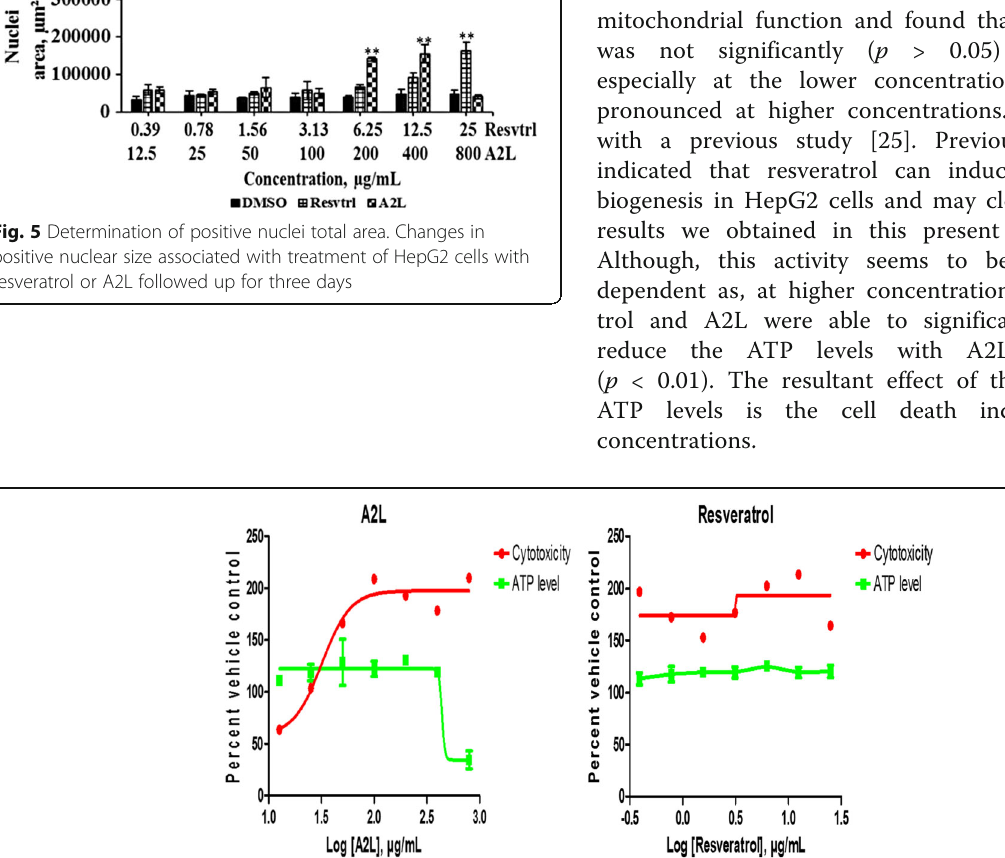
Fig. 6 Assessment of mitochondrial toxicity. Changes in the levels of cytotoxicity/membrane integrity (MI) and ATP determine if a treatment is